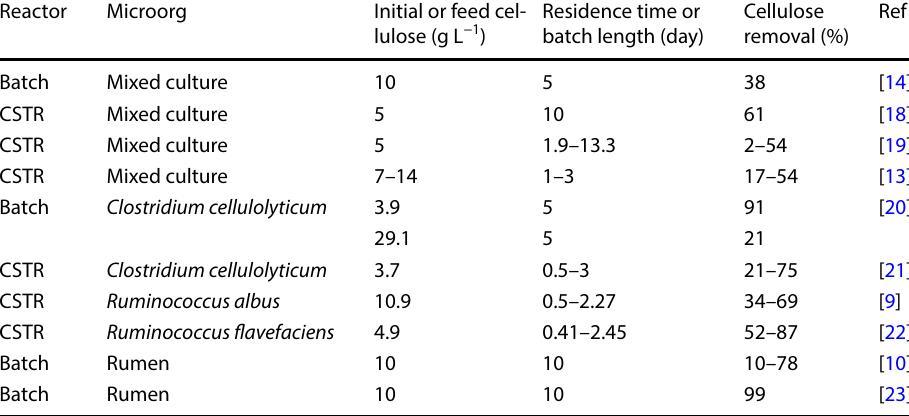
Table 1 Cellulose removal in selected literature